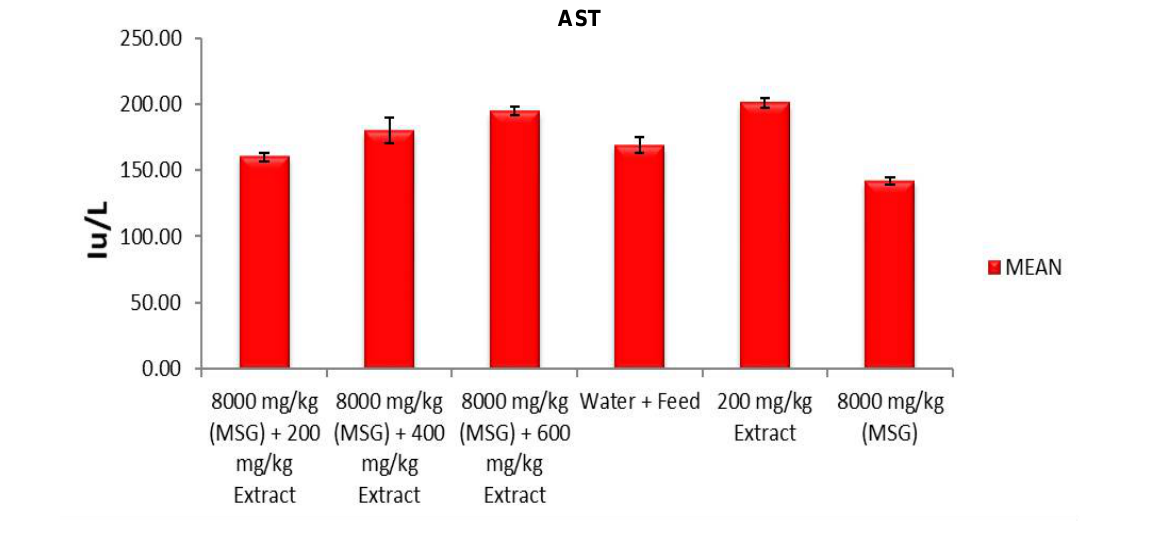
Figure 1: Effect of methanol extract of N. laevis on AST activity (IU/L) of the